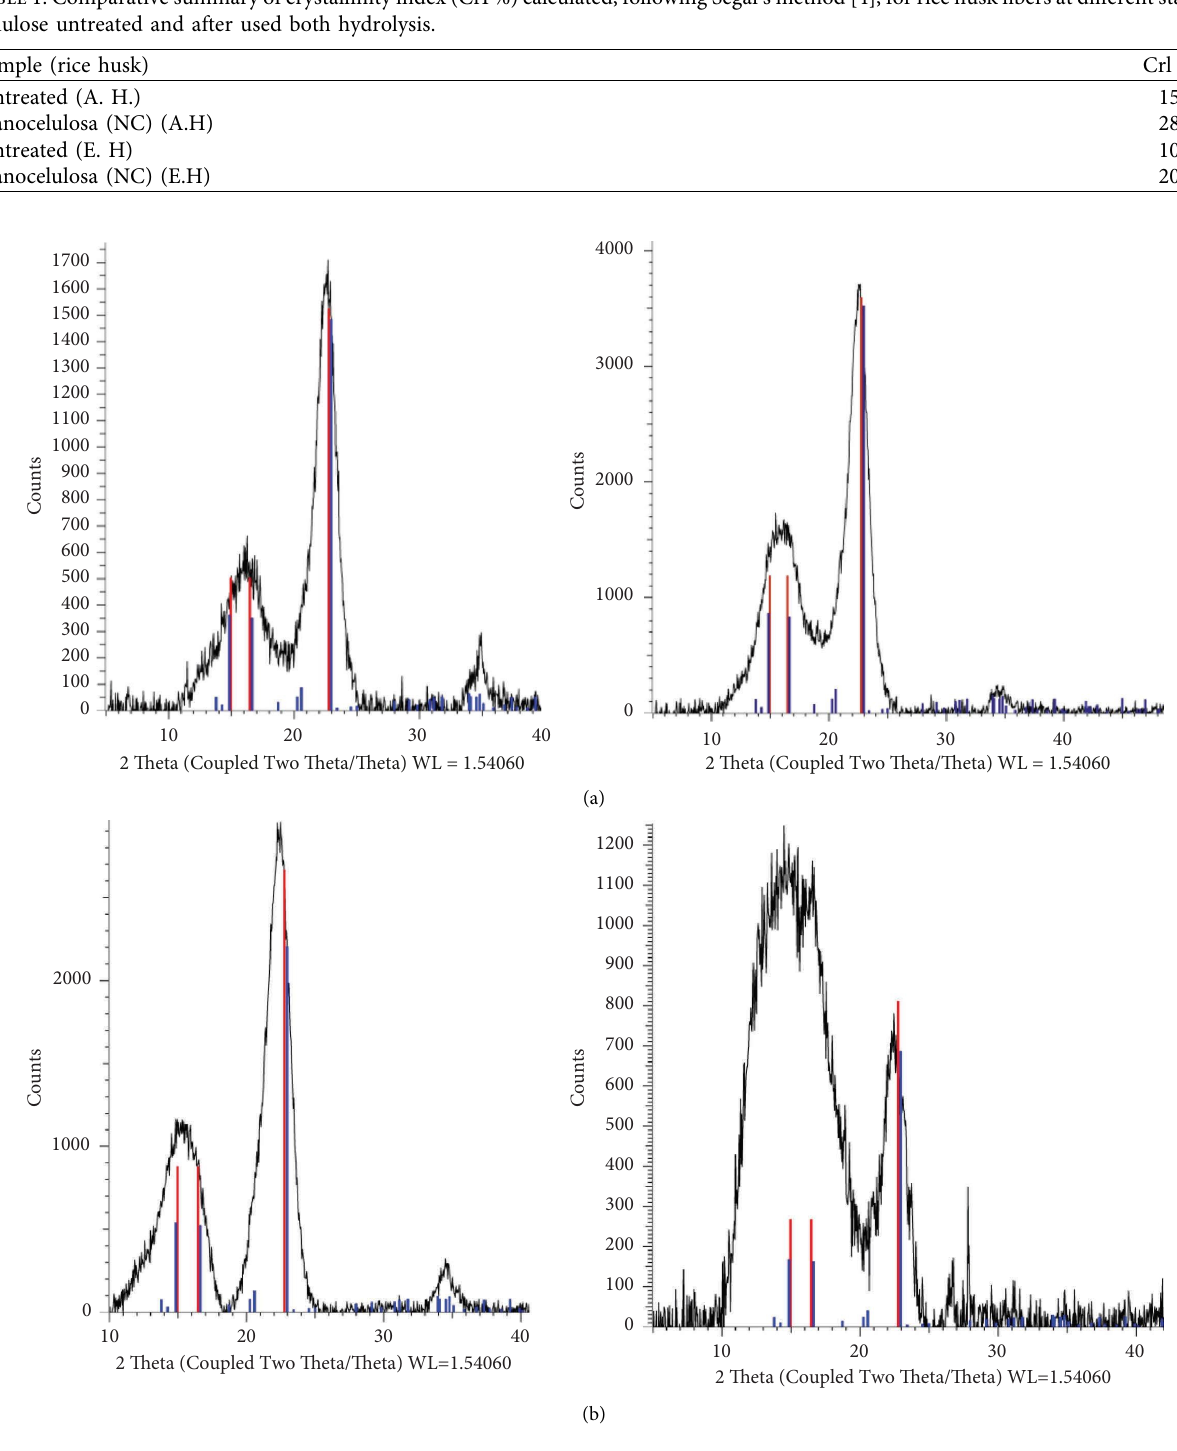
Figure 8: (a) Difraction peaks obtained in the X-ray (XRD) analysis for three samples: original cellulose (C1), untreated, samples (C8) processed by enzymatic hydrolysis. Te difraction peaks obtained show the two highest values of crystallization formed. Author himself. (b) A sample of the difraction peaks obtained in the X-ray difraction (XRD) analysis for two samples: the original cellulose (B2) untreated and samples (B4) processed by acid hydrolysis. Te difraction peaks obtained show the two highest values of crystallization formed. Author